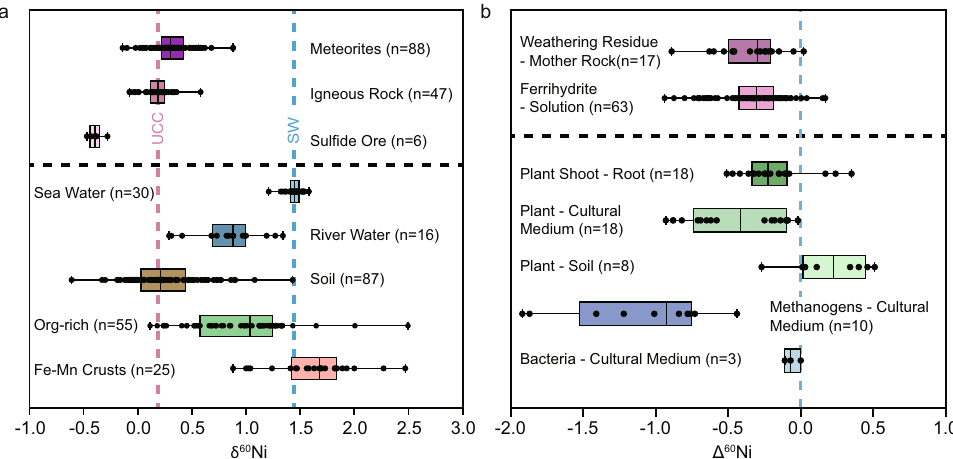
Fig. 5 Compilations of the Ni isotopes data. a Boxplots showing the Ni isotopic compositions of different reservoirs 29 – 31,42,43,67 – 70 . The box showing the range for δ 60 Ni value between upper and lower quartiles. The vertical line inside the box represents the median value, while that outside the box represents the maximum and minimum value. The red and blue dash lines represent the upper continental crust (UCC) and modern seawater compositions, respectively 28,66 . b Boxplot showing the Ni isotopic fractionations in various geochemical processes 29,38 . The weathering process preferentially dissolves heavy Ni, and laboratory experiment shows preferential absorption of light Ni in ferrihydrite precipitation 41 . Plants and methanogens preferentially absorb light Ni (ref. 25